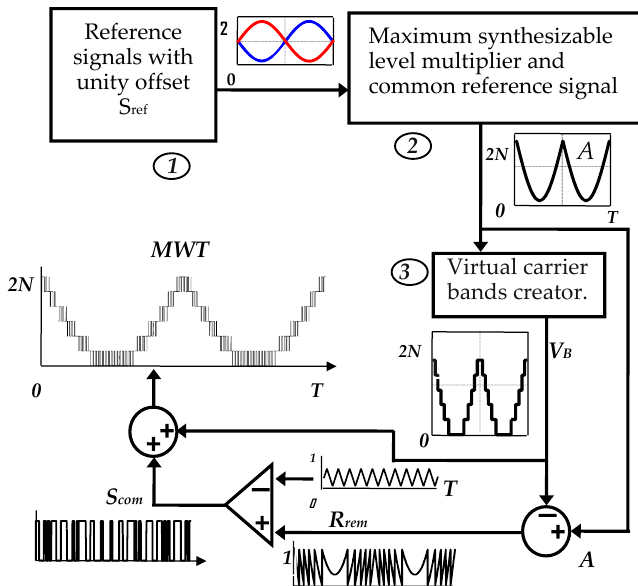
Figure 3. Outline of the multilevel waveform template, MWT, creation .